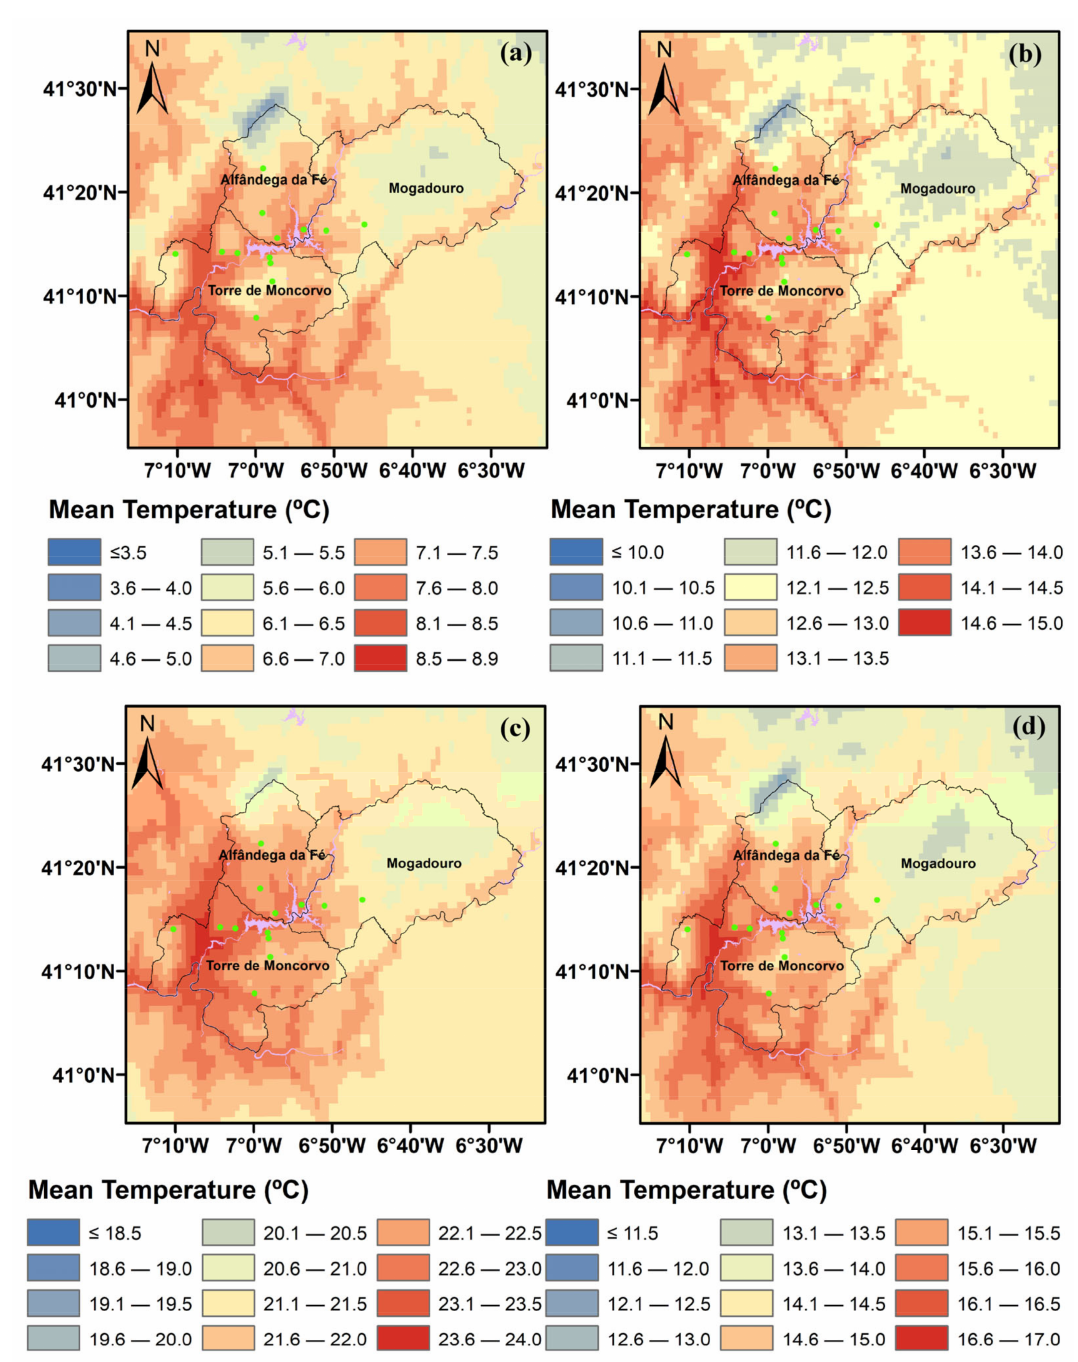
Figure 2. Spatial distribution of mean temperature in the target region of the Baixo Sabor Hydroelectric Plant (BSHP) for the period 2011–2020: ( a ) winter; ( b ) spring; ( c ) summer; and ( d )